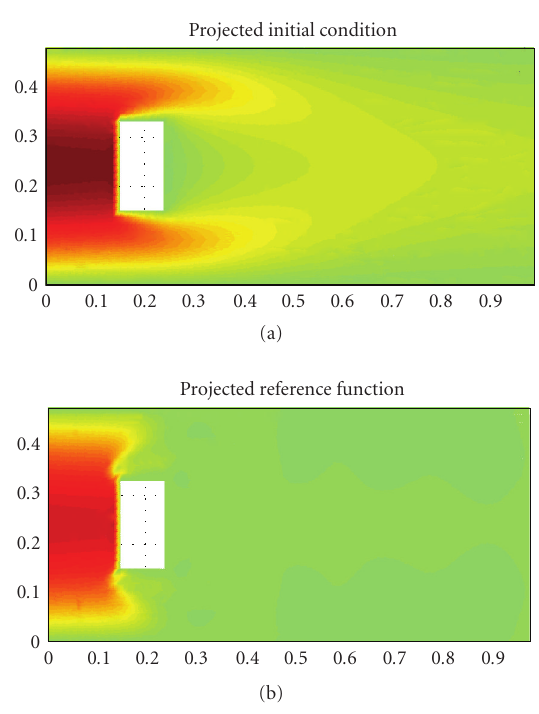
Figure 10: Flow initial condition and reference.